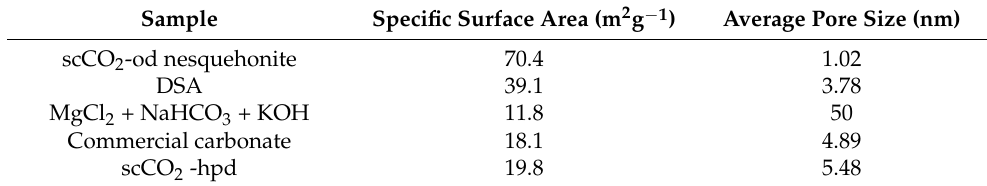
Figure 7. ( a ) BET adsorption isotherms (adsorbed amount cm 3 g −1 vs. relative pressure) of the DSA product, scCO 2 -hpd, and scCO 2 -od. ( b ) Pore volume cm 3 g –1 vs. pore width (nm) of DSA and nesquehonite product (scCO 2 -od) calculated by density functional theory (DFT). The apparent pores of ≈50 µm are considered a result of experimental noise, since no pores of these sizes were observed in the SEM ( c ) Cumulative specific pore volume cm 3 g −1 vs. pore width (nm) of the scCO 2 -hpd product. Table 3. Specific surface areas and average pore sizes for different magnesium carbonates.